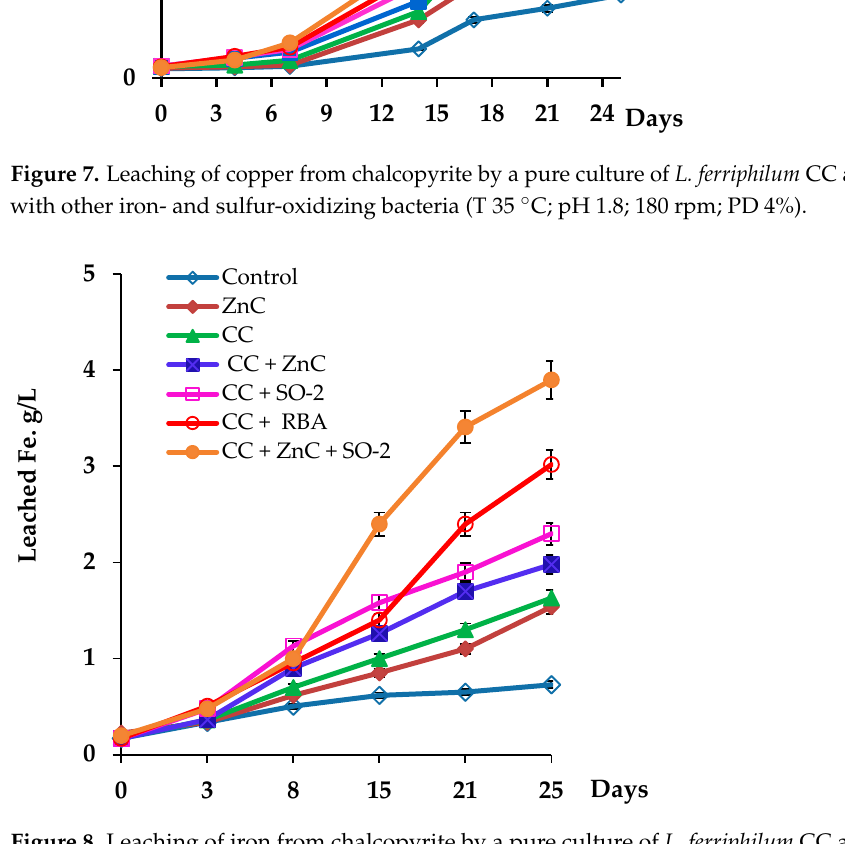
Figure 8. Leaching of iron from chalcopyrite by a pure culture of L. ferriphilum CC and association with other iron- and sulfur-oxidizing bacteria and Acidocella sp. RBA heterotrophic bacteria (T 35 °C; pH 1.8; 180 rpm; PD 4%). Table 3. Leaching of iron and copper from chalcopyrite by L. ferriphilum CC and association with iron- and sulfur-oxidizing and heterotrophic bacteria.